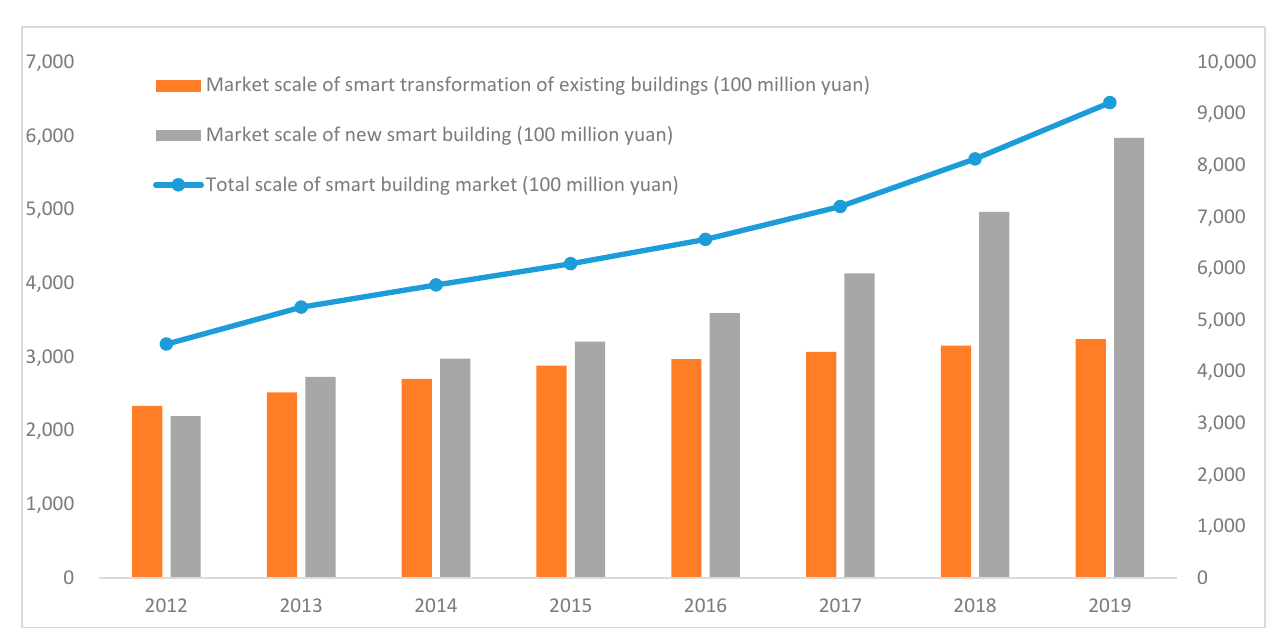
Figure 3. The market size of the smart building in China.